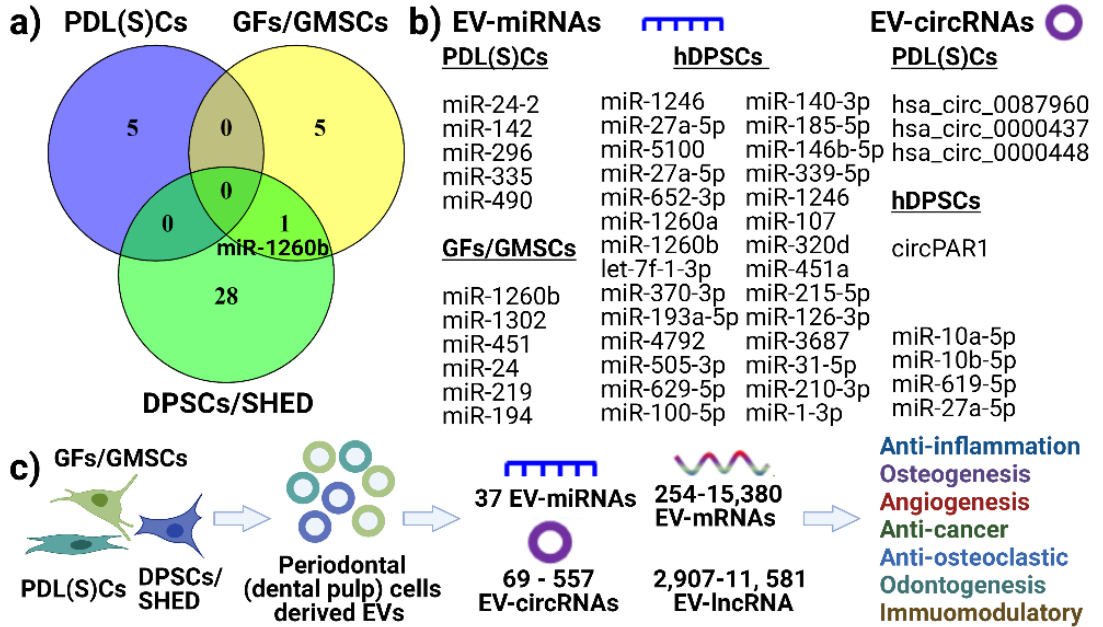
Figure 4. Summary of EV–miRNAs, circular RNAs ( a , b ) and proposed ( c ) function of periodontal cell-derived EV on recipient cells function. ( a ) Venn diagram showing no common EV–miRNAs found from PDL(S)Cs, GFs/GMSCs and DPSCs. ( b ) Listed EV–miRNAs and EV–circRNAs. ( c ) Proposed mechanism of how periodontal cell-derived EVs modulate inflammation, angiogenesis, osteo/odontogenesis via EV cargos, such as miRNA, mRNAs, lncRNAs, and circRNAs.